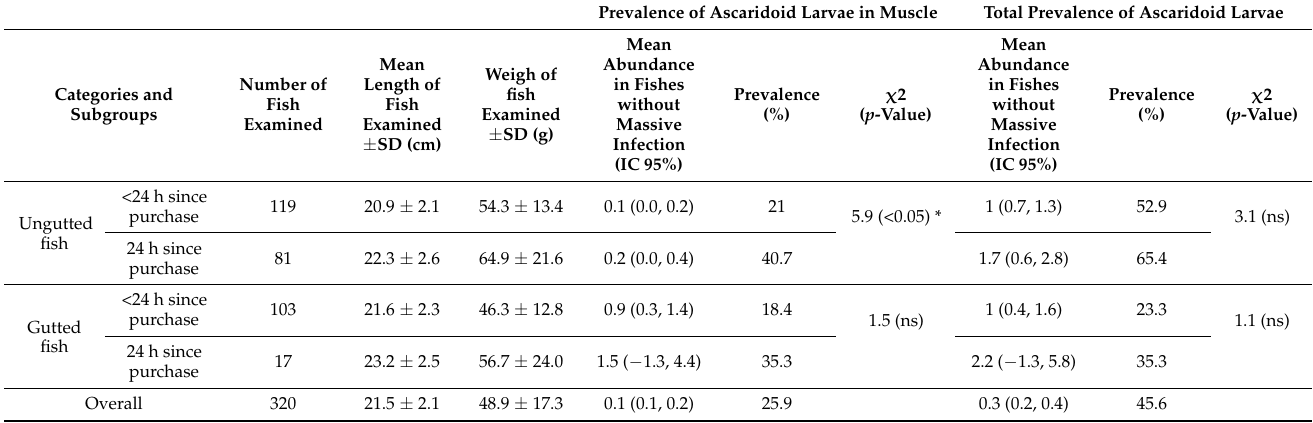
Table 1. Total prevalence (number of infected blue whiting, Micromesistius poutassou compared to the total number of fish examined for each subgroup) and mean abundance of ascaridoid larvae (number of larvae found in fish without massive infection divided by the number of fish examined in each subgroup) in all fish analyzed and in muscle (mean abundance was calculated only in fishes without massive infection). The percentages represent the proportion of infected fish to the total number of examined fish. * p -value < 0.05 was considered significant. “ns” = not statistically significant. Prevalence of Ascaridoid Larvae in Muscle Total Prevalence of Ascaridoid Larvae